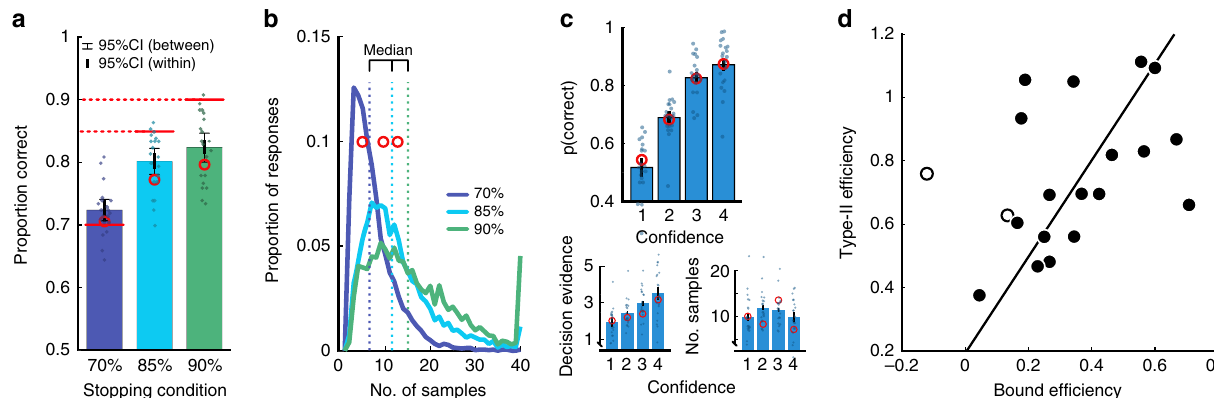
Fig. 3 The relationship between Type-I bound ef fi ciency and Type-II ef fi ciency. a Average proportion correct in each condition of the Stopping task. The horizontal red lines subtend the target performance level in each condition. Error bars show 95% within-subjects (thick) and between-subjects (thin) con fi dence intervals n = 20. The red circles show the predicted performance based on the fi tted parameters of the model. b Average proportion of trials by the number of samples the observers chose to respond to in each condition of the Stopping task. Vertical dashed lines show the average median number of samples. Red circles show the predicted median number of samples based on the fi tted parameters of the model. c Proportion correct (top), decision evidence (bottom left) and number of samples (bottom right) by con fi dence rating in the Replay task. Error bars show 95% within-subjects con fi dence intervals ( n = 20), and red circles show the predicted performance at each con fi dence level based on the fi tted parameters of the model. d Each observer ’ s bound ef fi ciency ( x -axis) by their Type-II ef fi ciency ( y -axis) and the line minimising the perpendicular distance from these points, here shown excluding two outlier participants (open circles) whose optimal bound was estimated using maximum performance rather than 85% correct ( y = 1.5× + 0.2, p -value for slope = 0.026, one-sided, based on bootstrapping, with outlier participants removed).